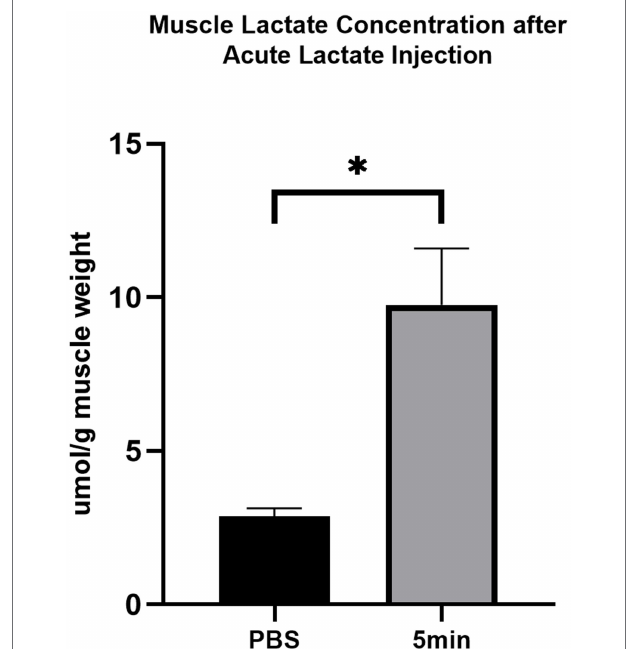
FIGURE 1 | The effect of acute intramuscular lactate injection on the injected gastrocnemius lactate concentration. The muscle lactate concentration was measured 5 min after PBS and lactate injection. The data are presented as the mean ± SD, and significant differences between the two groups were analyzed with the independent-samples t -test. * p < 0.05 vs. 0